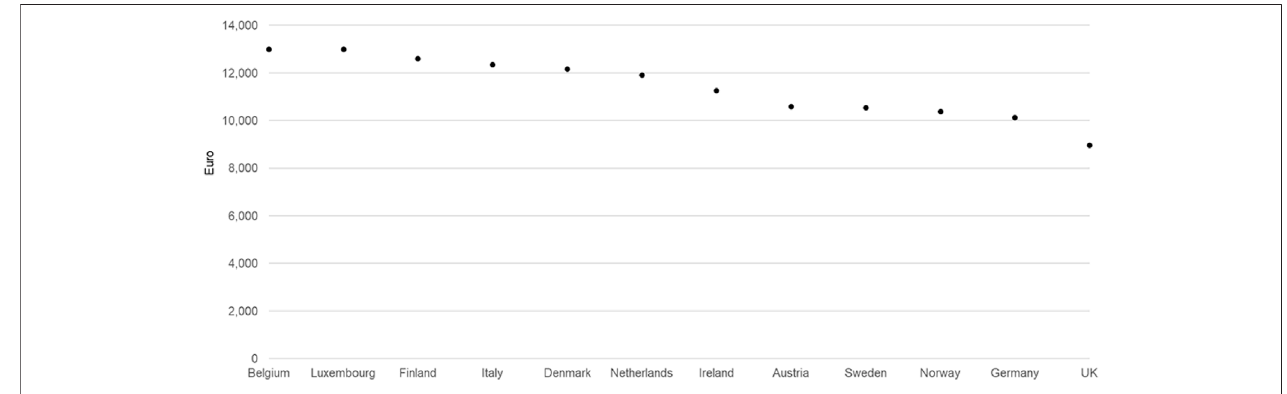
FIGURE 3 | Lumacaftor/ivacaftor ex-factory prices in all European countries where listed (200mg/125mg, 112x, November 2019